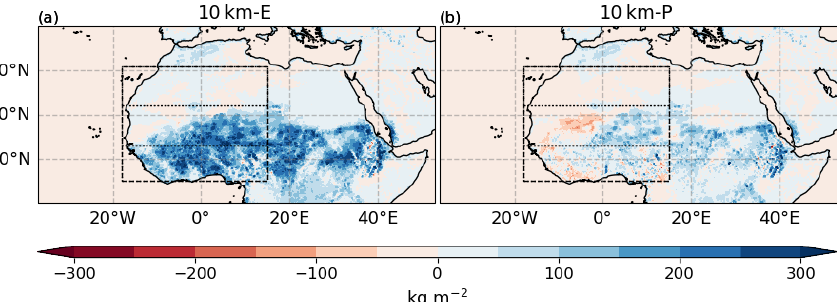
Figure B8. Difference of the JAS mean soil moisture content in the six uppermost soil layers between the GS-cSM and the GS simulation for the 10km-E (a) and the 10km-P (b) simulations. The dashed black box indicates the WA analysis domain.